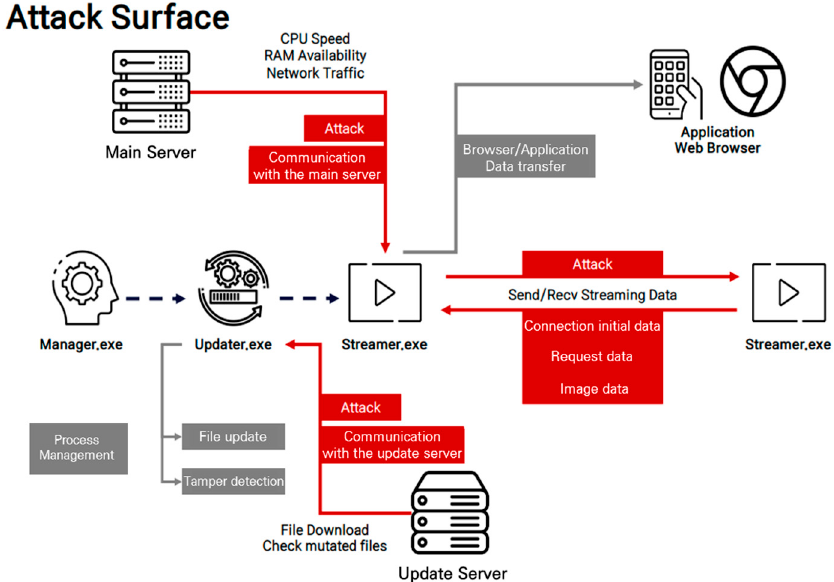
Figure 11. Attack surface discovered based on identified threats.